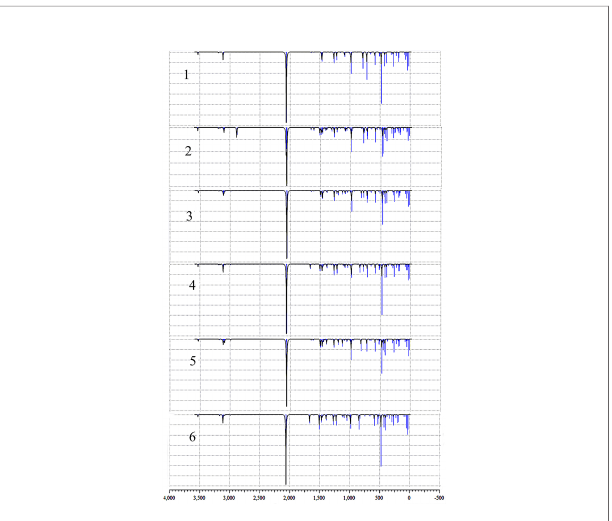
FIGURE 3 | Thecalculatedelectrostaticpotentialofcompounds1,2,3,4,5and6.